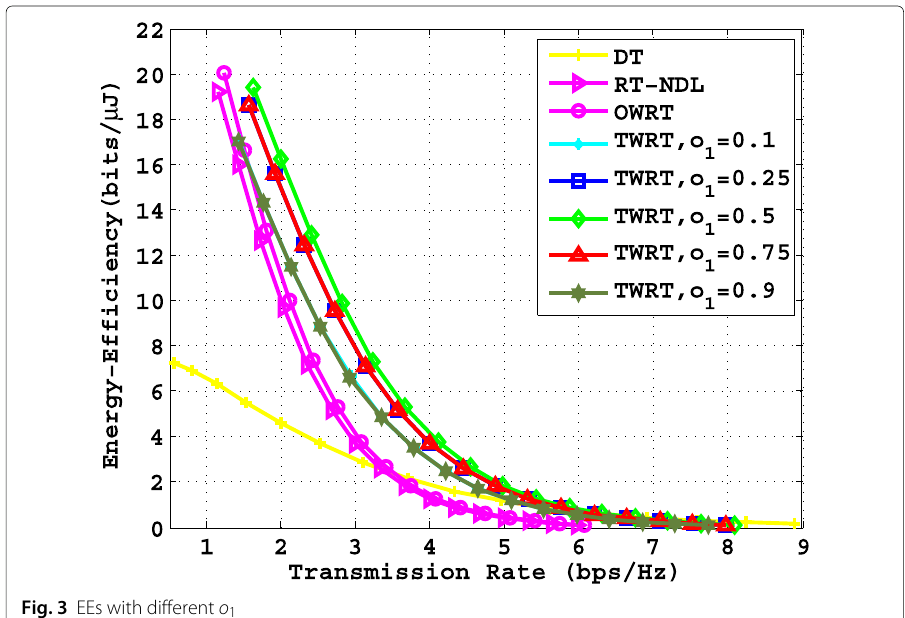
Fig. 3 EEs with different o 1